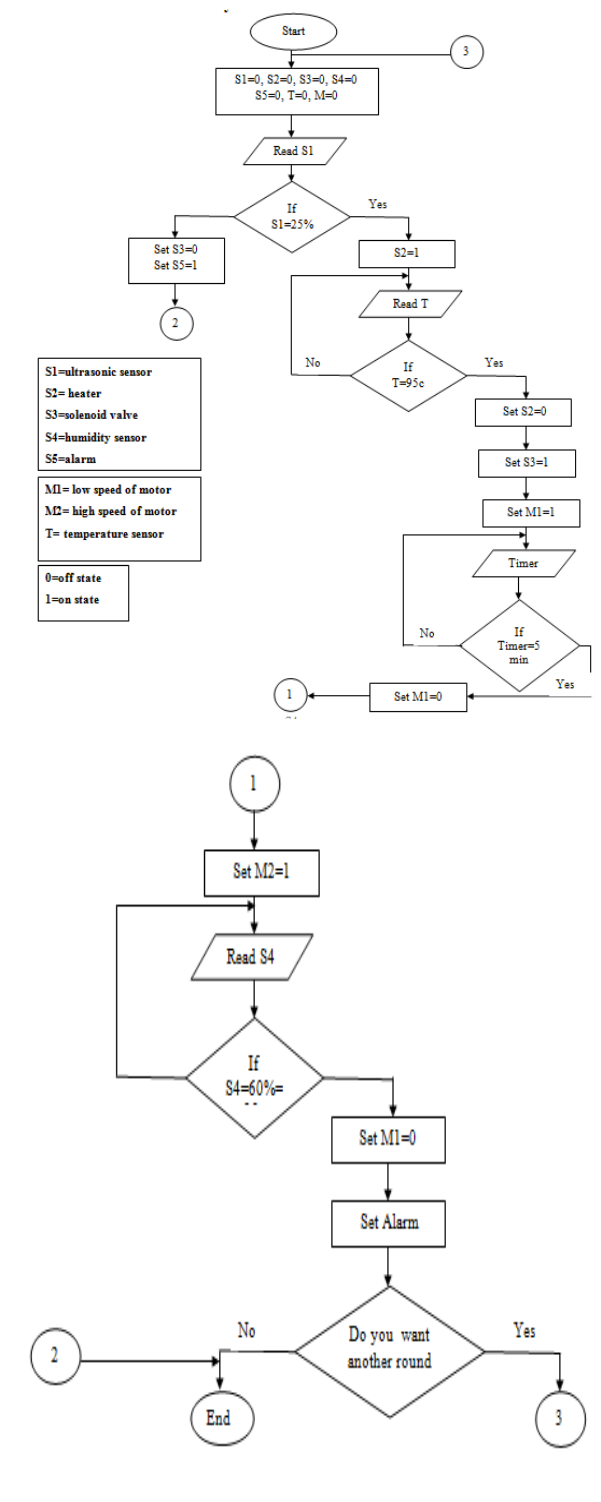
Fig. 7. The block diagram of the